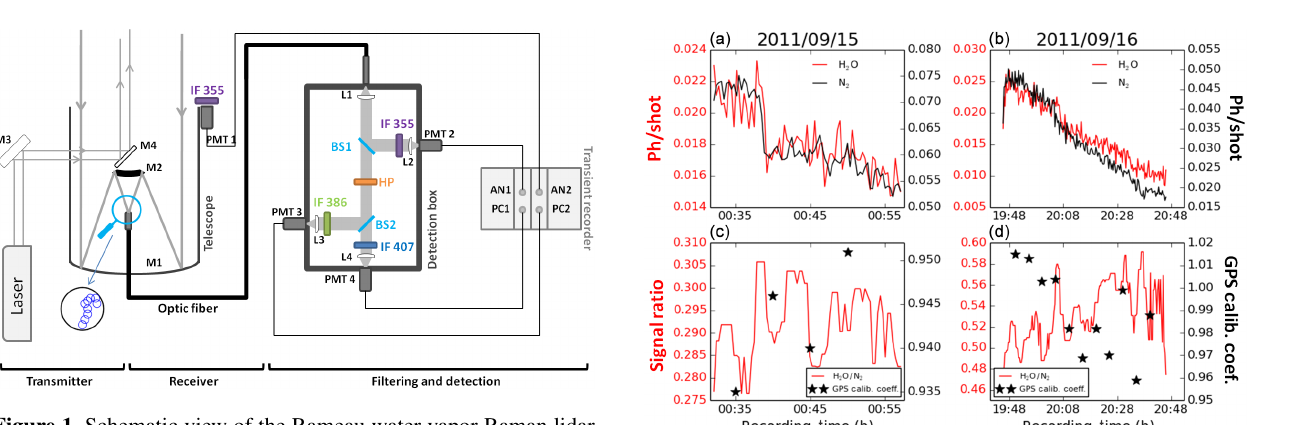
Figure 1. Schematic view of the Rameau water vapor Raman lidar system